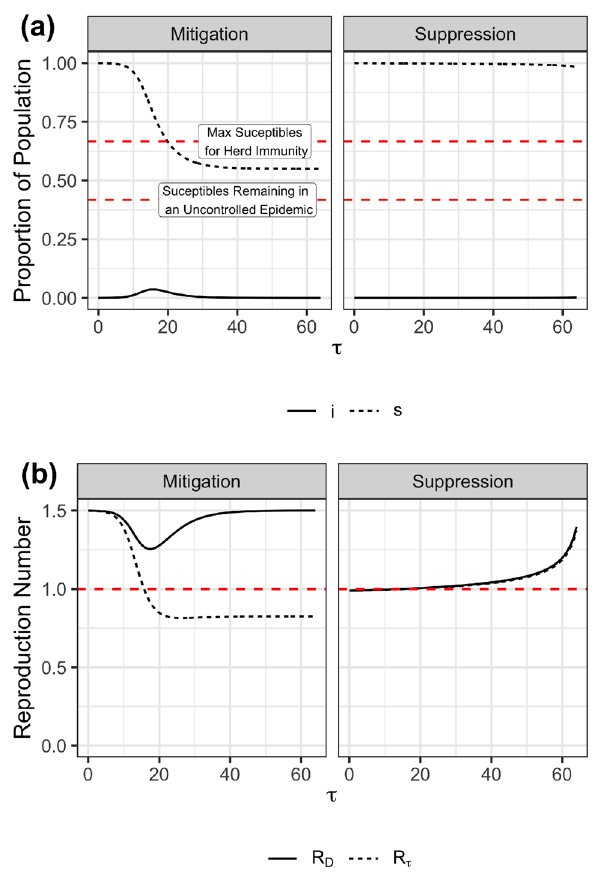
Figure 1. Mitigation vs. Suppression ( a ) The disease dynamics for the proportion of the population infected ( i ) and the proportion of the population susceptible ( s ) are shown. The horizontal line labeled “Max Suceptibles for Herd Immunity” shows s H and “Susceptibles Remaining in an Uncontrolled Epidemic” indicates s ∞ . ( b ) The dynamic reproduction number, R D , is shown over time as well as the effective reproduction number, R τ . The horizontal red line indicates where these variables are 1. In all panels, R 0 = 1.5 , i 0 = 10 The left and right panels in ( a ) and ( b ) differ in the value of c , the relative cost of social distancing compared to infections. The left panel shows the qualitative dynamics of a mitigation strategy. In this case c = 0.4 . The right panel shows the qualitative dynamics of a suppression strategy. In this case c = 0.025